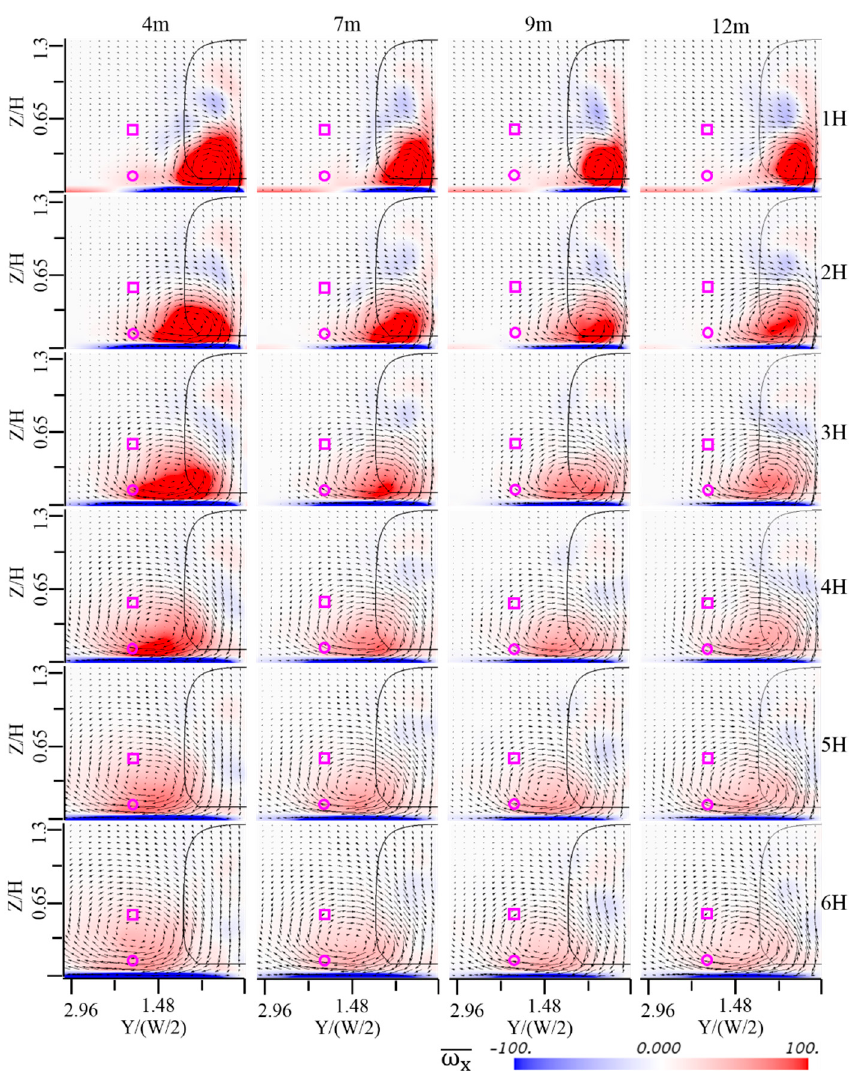
Figure 19. Time-averaged velocity vectors of vertical planes 1 H , 2 H , 3 H , 4 H , 5 H , and 6 H from tail of train, colored by time-averaged x-vorticity (hollow pink square: platform position; hollow pink circle: trackside position).